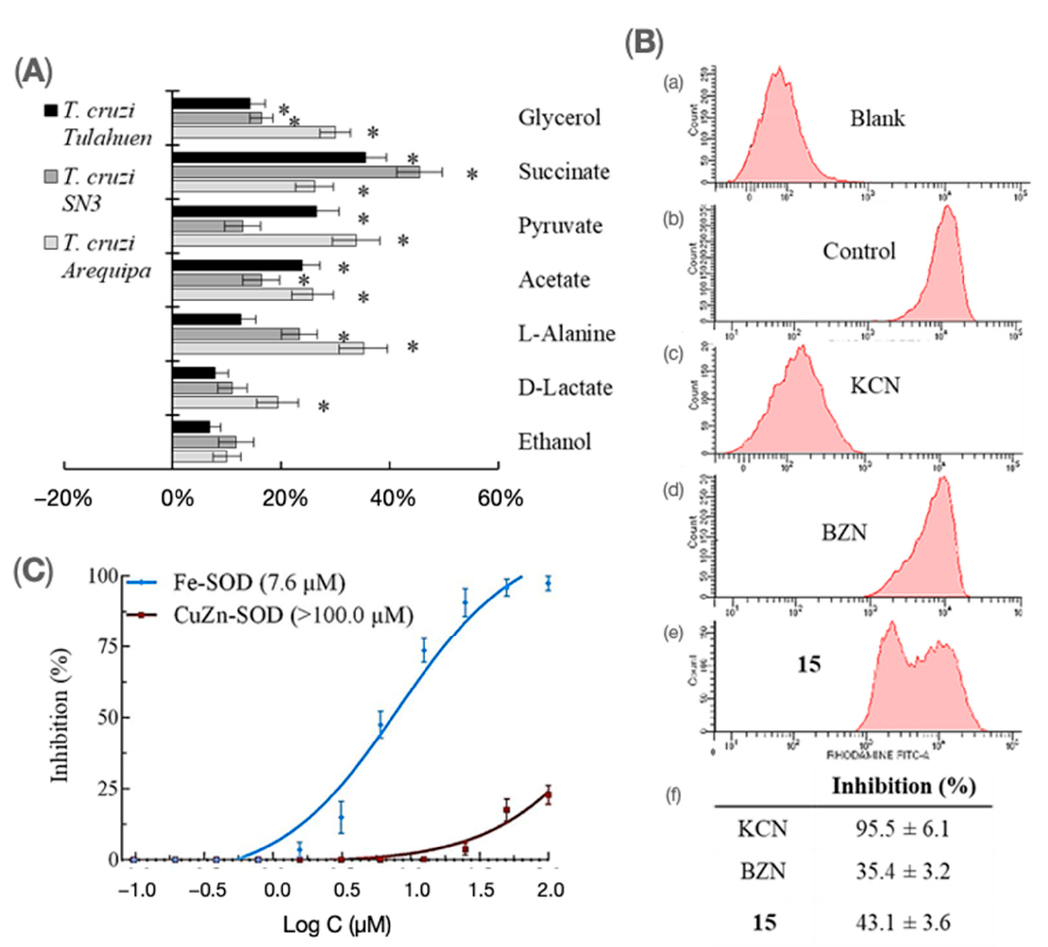
Figure 3. ( A ) Catabolites excreted by Trypanosoma cruzi epimastigotes exposed to 15 at IC 25 concentrations in comparison to untreated epimastigotes. Values are the mean of three separate determinations ± standard deviation. * Significant differences between untreated and treated epimastigotes ( p < 0.05). ( B ) Mitochondrial membrane potential from epimastigotes of Trypanosoma cruzi Arequipa strain exposed at IC 25 concentrations: ( a ) blank, ( b ) control (untreated), ( c ) potassium cyanide (KCN), ( d ) BZN, ( e ) 15 , ( f ) Inhibition on mitochondrial membrane potential with respect to untreated epimastigotes. Values are the mean of three separate determinations ± standard deviation. Significant differences between untreated and treated epimastigotes ( p < 0.05). ( C ) Inhibition of Trypanosoma cruzi Fe-SOD—activity 42.0 ± 3.8 U·mg − 1 —and human erythrocytes CuZn-SOD—activity 47.3 ± 4.1 U·mg − 1 —for 15 . Values are the mean of three separate determinations ± standard deviation. In brackets: IC 50 value.